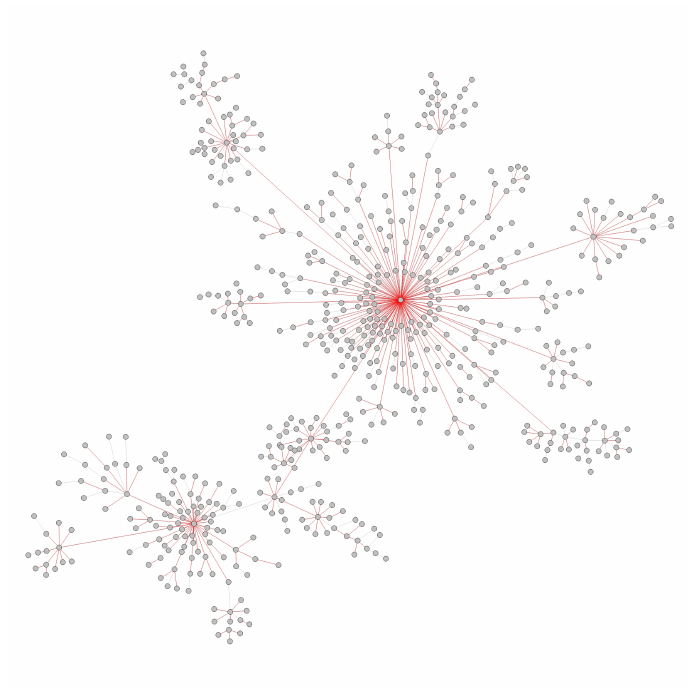
Figure A8. Abnormal edges in New Zealand transmission